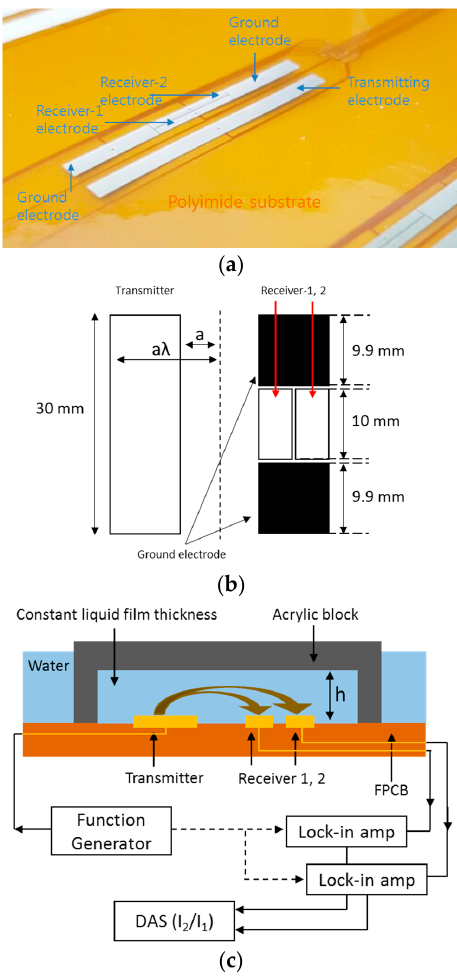
Figure 2. ( a ) configuration of the electrodes; ( b ) specific dimensions of the electrodes; and ( c ) calibration experiment and circuitry setup.